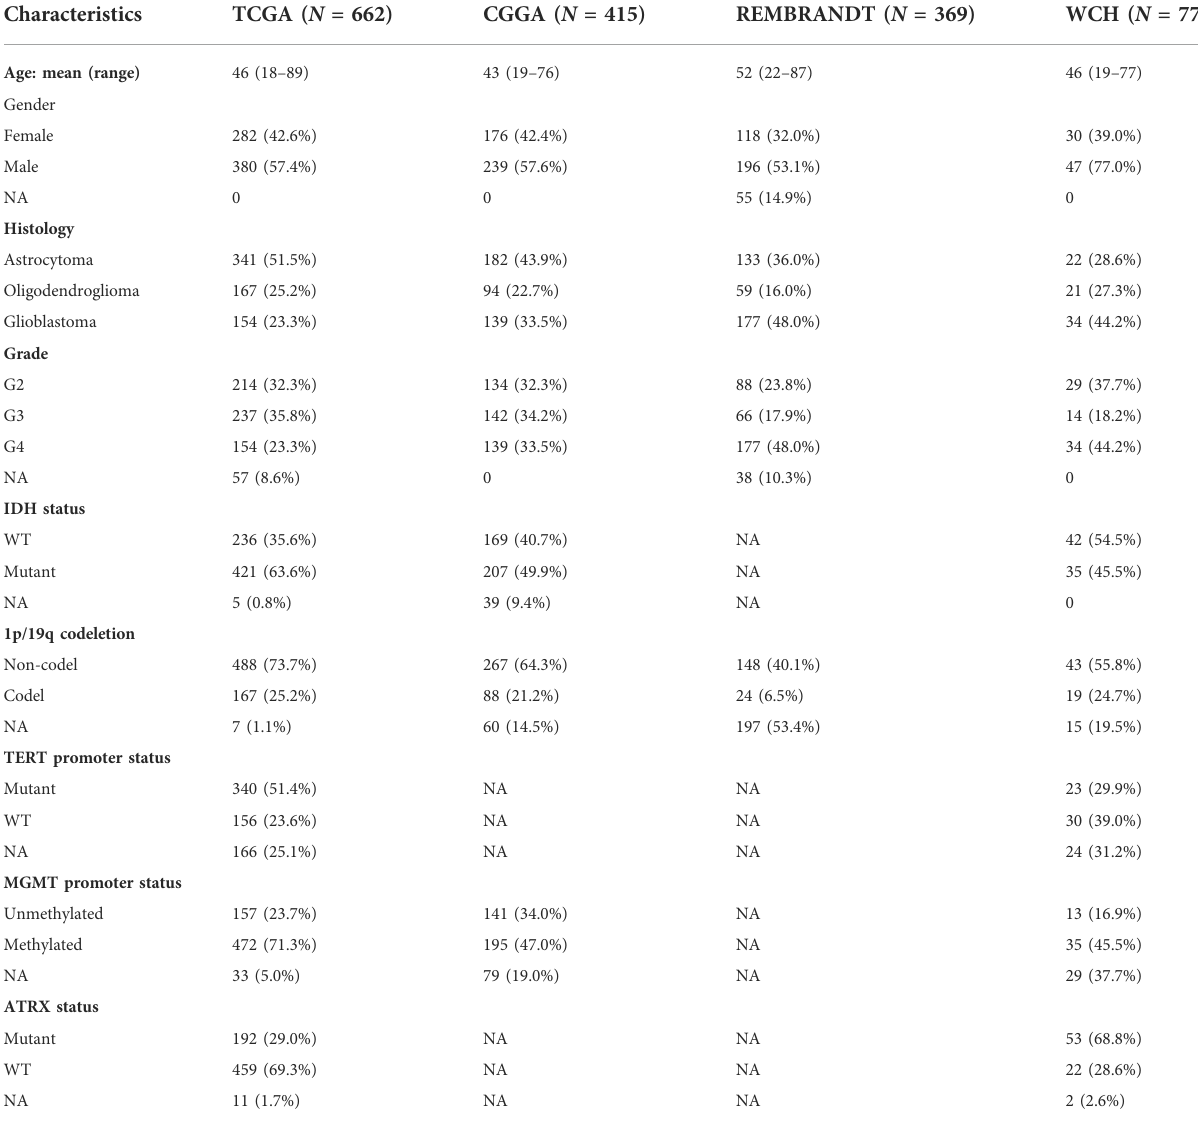
TABLE 1 Clinicopathological characteristics of patients in TCGA, CGGA, REMBRANDT, and WCH cohort.